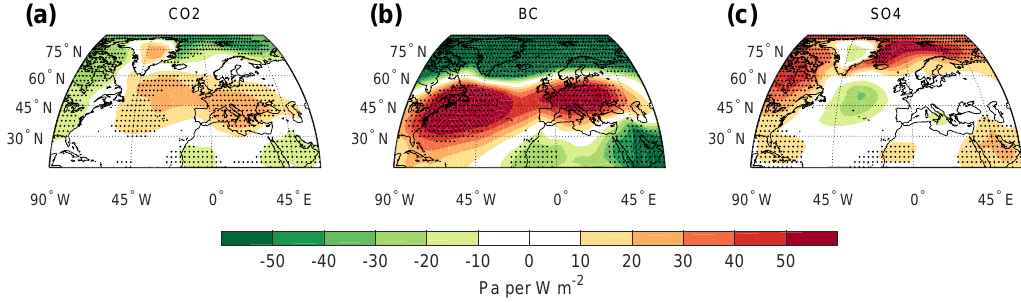
Figure 4. Same as Fig. 1, but for sea level pressure